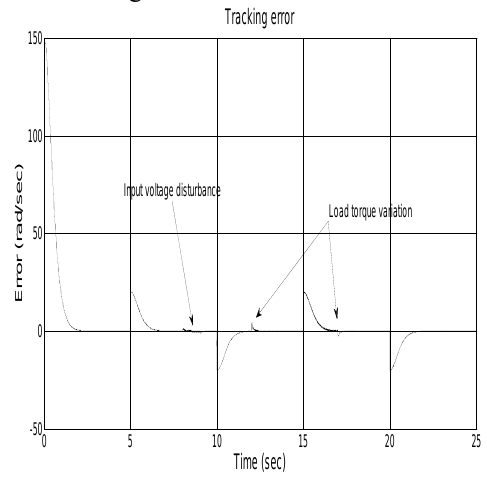
Figure 5.asymptotic convergence of tracking error.